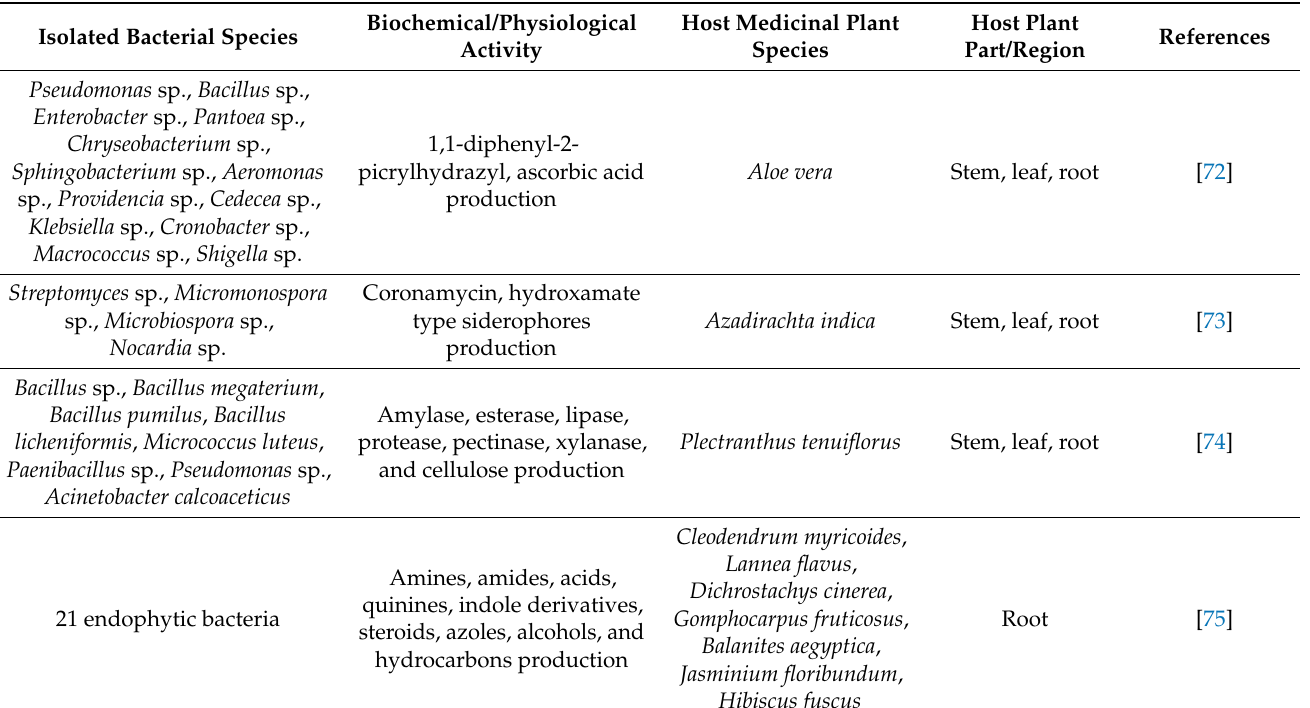
Table 1. Endophytic bacteria with antimicrobial activity and associated secondary metabolites from medicinal and herbal plant